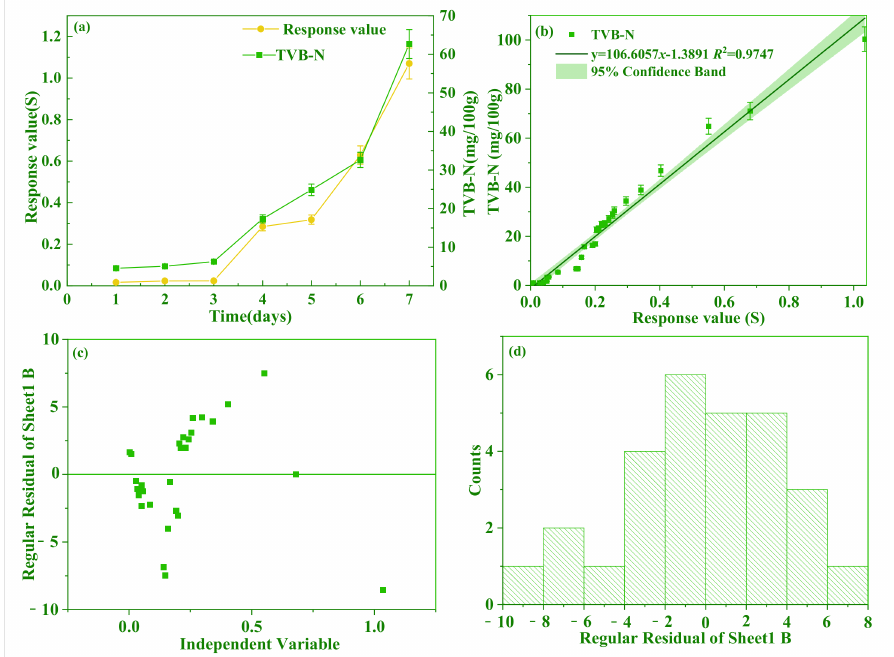
Figure 8. The changes of TVB-N and response value of the sensor to pork with storage time ( a ); the correlation between TVB-N contents to sensor response values ( b ); distribution diagram of regular residual ( c ); histogram of regular residuals ( d